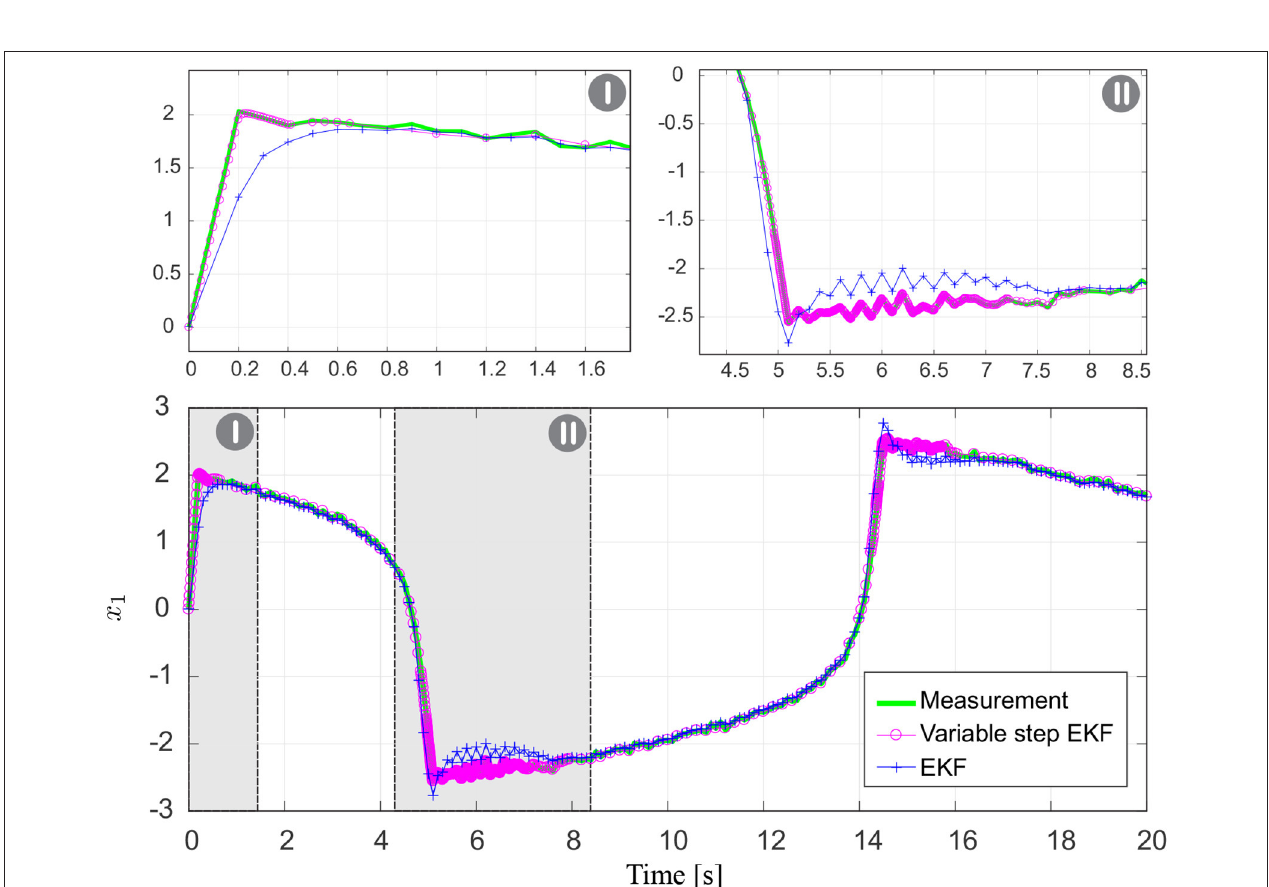
FIGURE 2 | Estimation of Van der Pol oscillator first state x 1 using fixed and variable step size Extended Kalman Filter.